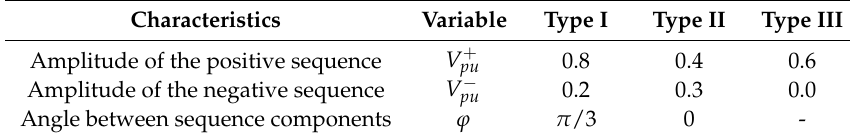
Table 3. Characteristics of the voltage sags used in the